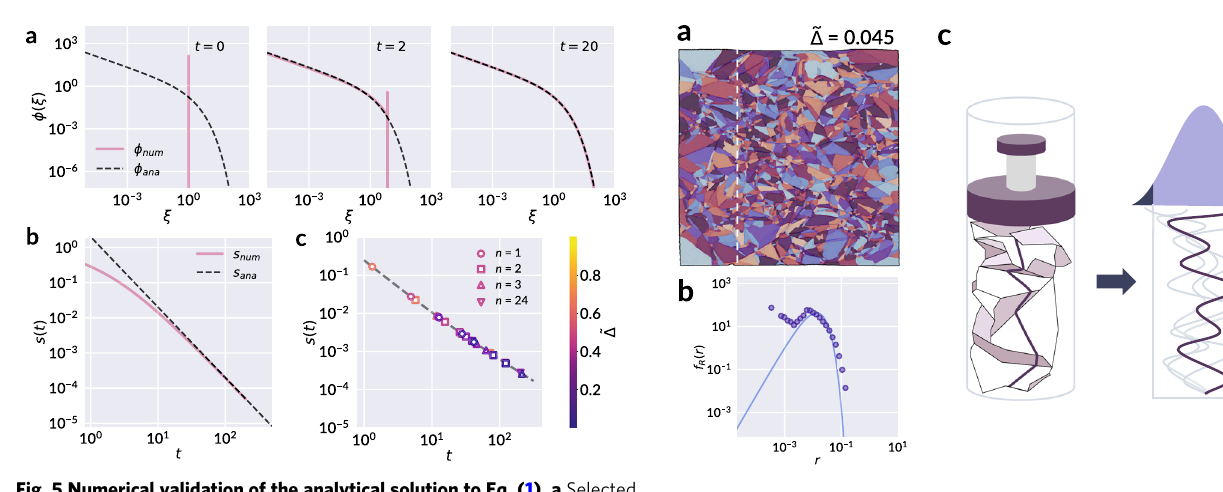
Fig. 5 Numerical validation of the analytical solution to Eq. (1). a Selected snapshots of the numerically calculated ϕ num ( ξ ) with initial condition c ( x , 0) = δ ( x − 1) and with a = 1, revealing a rapid convergence to the steady state distribution. The dashed line corresponds to the analytical form of Eq. (7a) valid at large t . b The corresponding evolution of mean area s ( t ), with the analytical solution at large t given by Eq. (7b) shown by the dashed line. c The mean area of the experimental samples as a function of t computed from Eq. (7b) (scattered points). The dashed line corresponds to Eq. (7b) with a ( t ) as given by Eq. (8). Marker colors correspond to different values of ~ Δ , as indicated by the colorbar.